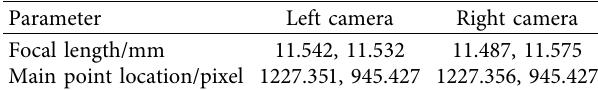
Table 1: Calibration results of left and right cameras. Parameter Left camera Right camera Focal length/mm